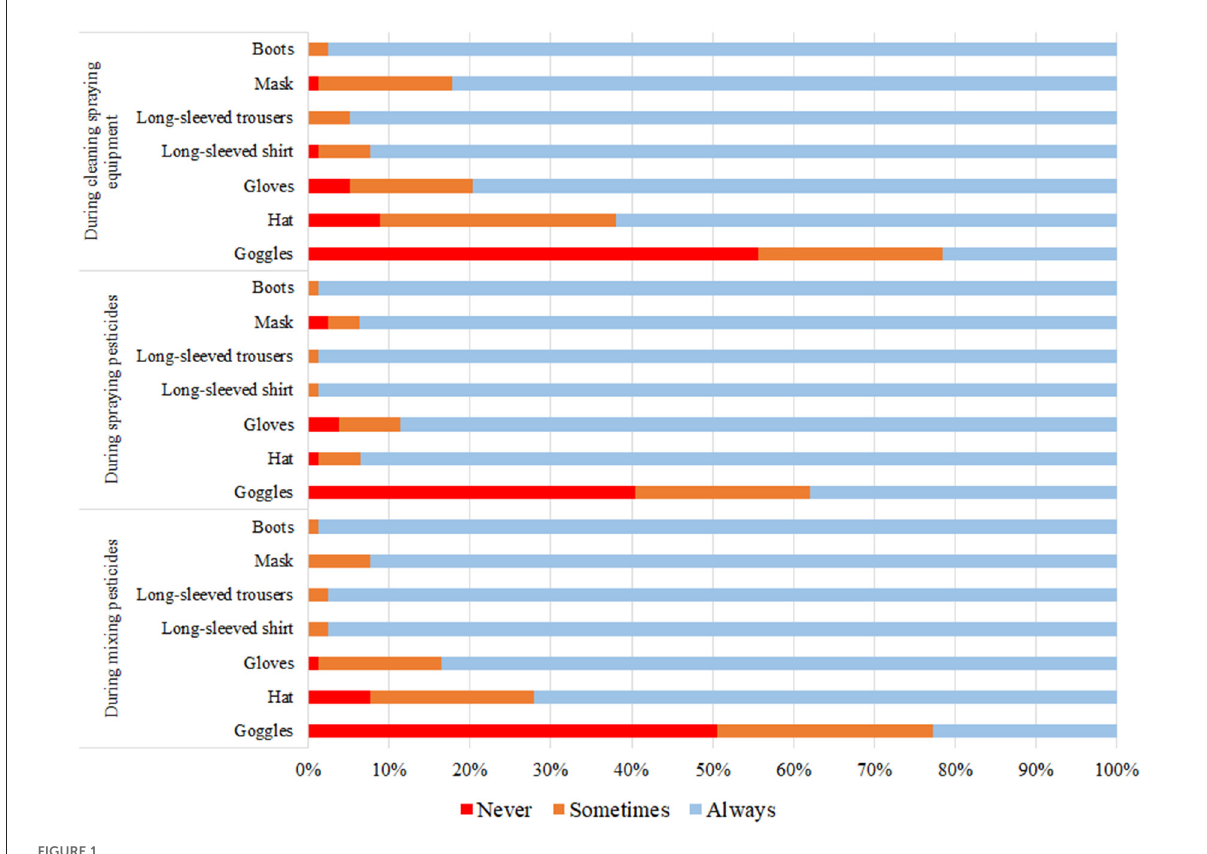
FIGURE1 PPE use during pesticide application.